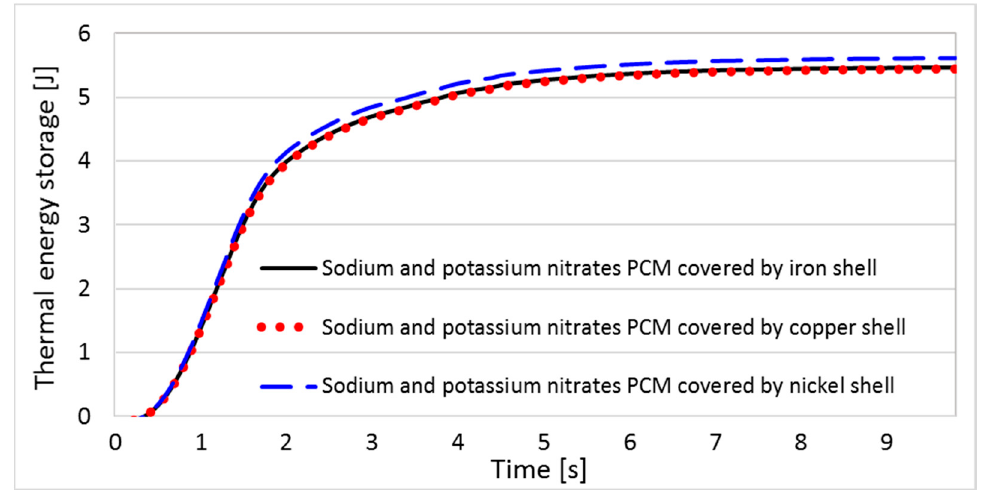
Figure 2. EPCMs thermal energy as a function of the time.